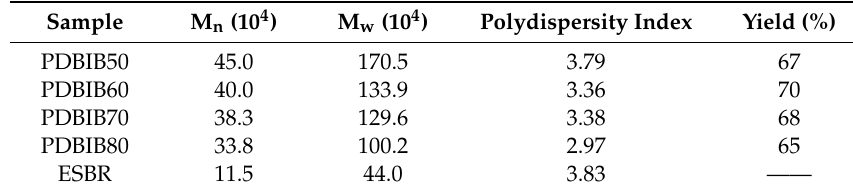
Scheme 1. Polymerization reaction of PDBIB. Table 4. Molecular weight and yield of PDBIB and Table 4. Molecular weight and yield of PDBIB and ESBR.